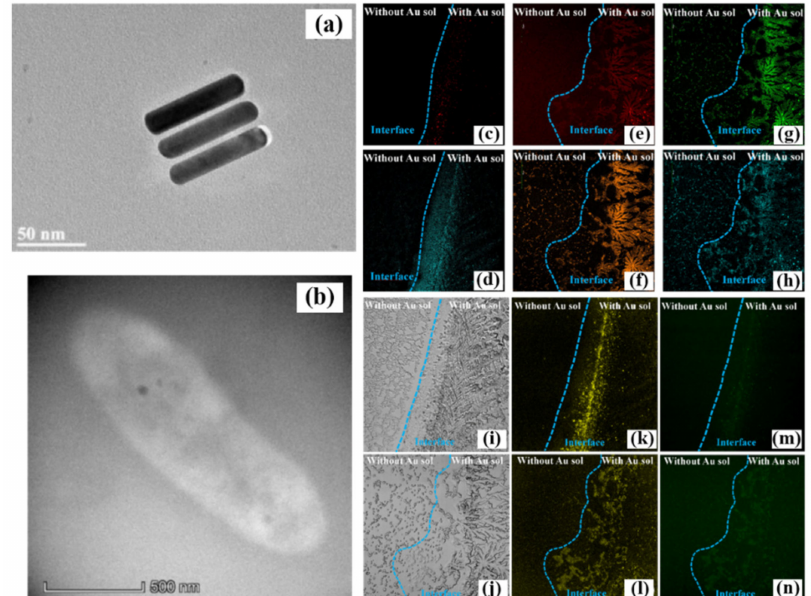
Figure 5. ( a , b ) are the TEM images of the self-assembled Au@Ag NRs and E. coli , respectively. ( c , d ) are the results of CARS imaging of E. coli at 1094 cm − 1 and 2933 cm − 1 , respectively. ( e – h ) are the CARS imaging results of S. aureus at 1094 cm − 1 ( e ), 1340 cm − 1 ( f ), 1589 cm − 1 ( g ) and 2933 cm − 1 ( h ), respectively. ( i – n ) are the TPEF imaging signals of E. coli and S. aureus under brightfield microscopy ( i , j ), 570–630 nm ( k , l ), and 495–540 nm ( m , n ) channel regions, respectively. In the nonlinear micro- scopic imaging image, the right and left sides of the blue dotted line are the regions with and without Au@Ag NRs, respectively [43]. Republished with permission from Ref. [43]. Copyright 2022